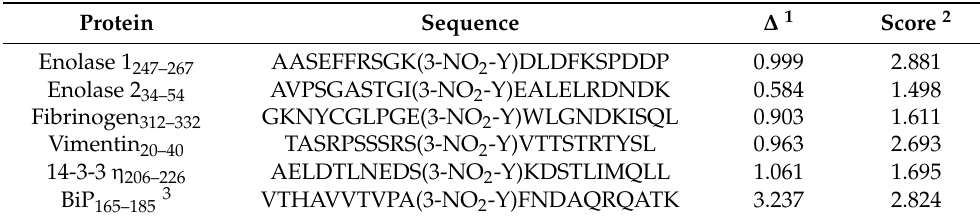
Table 3. The 10 synthetized 3-NT peptides with an indication of their position in the protein sequences, the nitrated residues (3-NO 2 -Y), and the probabilities of in vivo nitration according to two algorithms. Protein Sequence ∆ 1 Score 2 Enolase 1